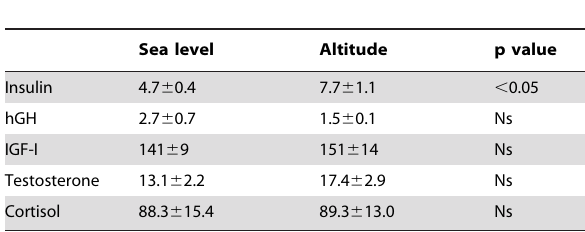
Table 3. Venous plasma hormonal